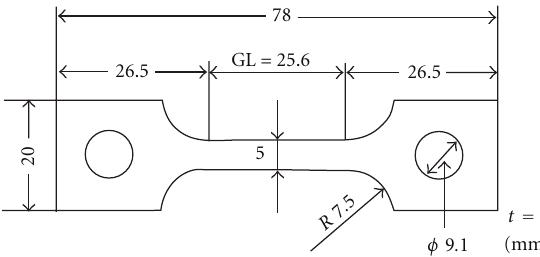
Figure 1: Geometry of specimens (dimensions in